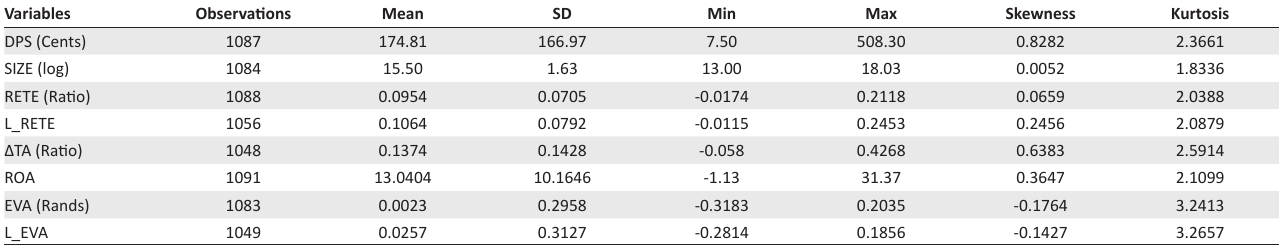
TABLE 1: Descriptive statistics for all variables of Panel 1: Full sample. Variables